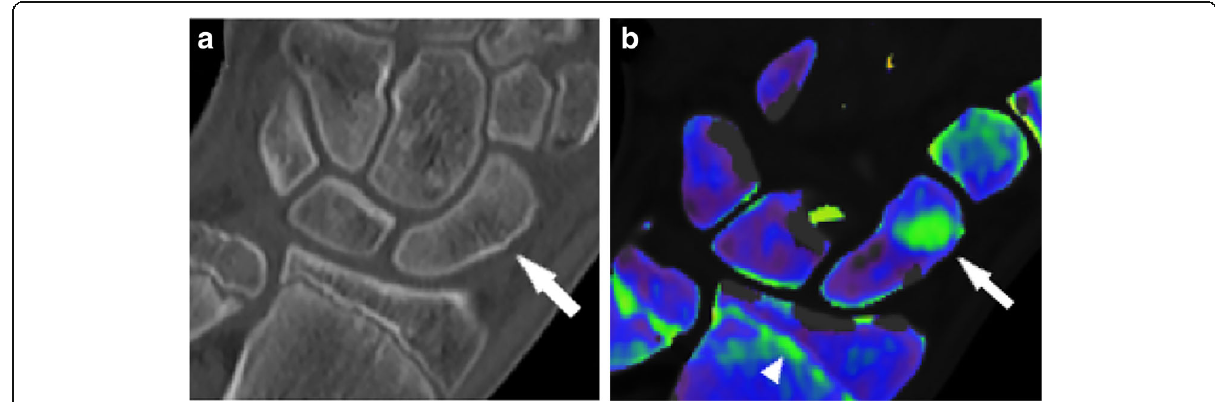
Fig. 4 Hand dual-energy computed tomography scan in a patient with a non-displaced scaphoid fracture, which was confirmed at magnetic resonance imaging (not shown). Standard grayscale series ( a ) shows a subtle cortical interruption, which is not clearly suggestive for fracture ( arrow ). Color-coded virtual non-calcium image ( b ) depicts the presence of bone marrow edema confirming the hypothesis of a traumatic lesion. Of note, the epiphyseal line on the distal radius and ulna are also color-coded in green ( arrowhead ). From Dareez et al.